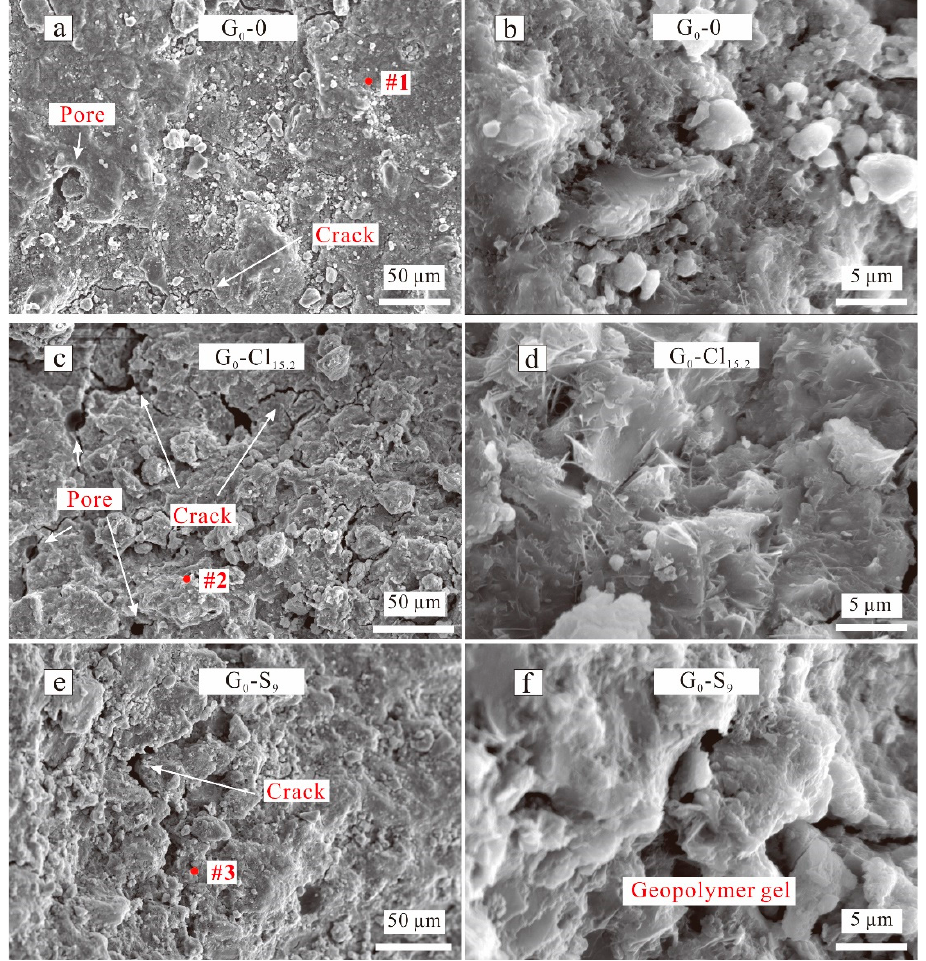
Figure 8. SEM images of NaOH-activated geopolymers of ( a ) G 0 -0, ( c ) G 0 -Cl 15.2 , ( e ) G 0 -S 9 at low magnification; SEM images of NaOH-activated geopolymers of ( b ) G 0 -0, ( d ) G 0 -Cl 15.2 , ( f ) G 0 -S 9 at high magnification.